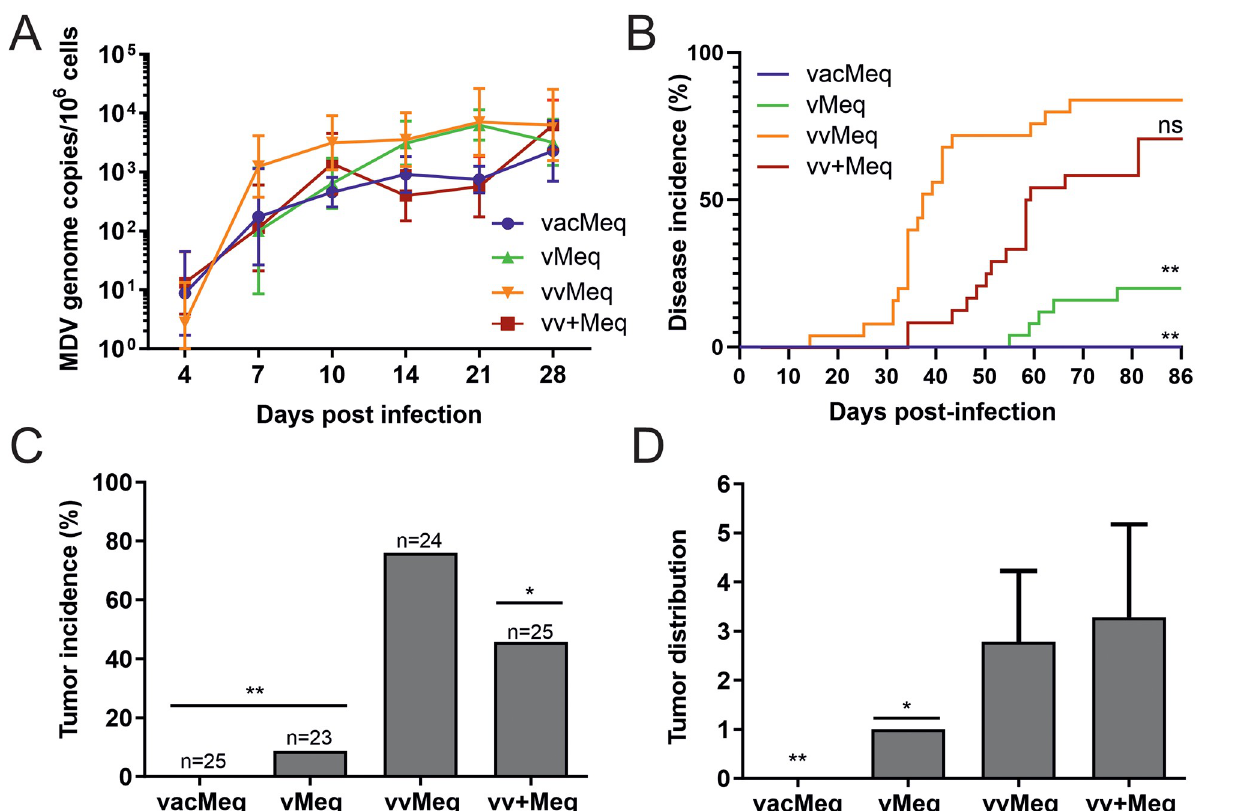
Fig 2. Influence of meq isoforms from various pathotypes on MDV pathogenesis. (A) MDV genome copies were detected in the blood samples of chickens infected with indicated viruses by qPCR. Mean MDV genome copies per one million cells are shown for the indicated time points (p > 0.05, Kruskal-Wallis test). (B) Disease incidence in chickens infected with indicated recombinant viruses and significant differences in comparison to vvMeq ( �� p < 0.0125, Log- rank (Mantel-Cox) test). (C) Tumor incidence as percentage of animals that developed tumors during the experiment. Asterisks indicate significant differences compared to vvMeq ( � p < 0.05 and �� p < 0.0125; Fisher’s exact test). (D) Tumor distribution is shown as the number of tumorous organs in tumor-bearing animals with standard deviations ( � p < 0.05 and �� p < 0.0125; Fisher’s exact test).